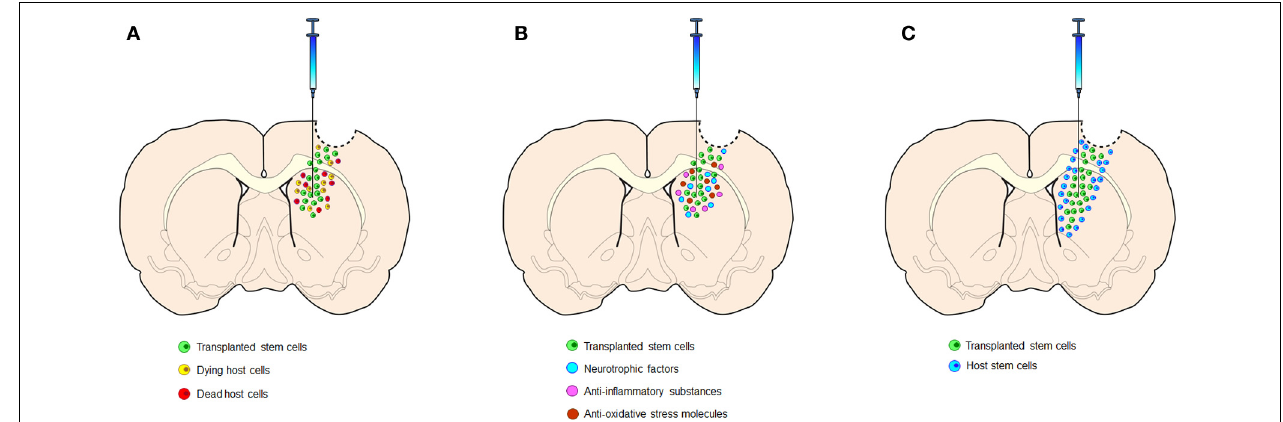
FIGURE 1 | Multiple mechanisms underlying stem cell therapy. (A) Cell replacement entails that transplanted cells replace dead or dying host cells, which would require neuronal differentiation of stem cells and reconstruction of the damaged synaptic circuitry. (B) By-stander effects involve secretion of neurotrophic factors, anti-inflammatory substances, and anti-oxidative stress